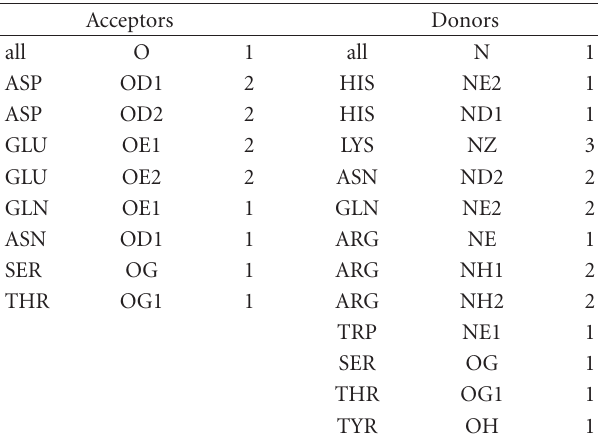
Table 1: List of the atoms considered as acceptors and donors. For both classes, the 3-letter codes of the amino acids, the symbol used in the PDB files of the considered atom, and the maximum number of hydrogen bonds of atom are reported.